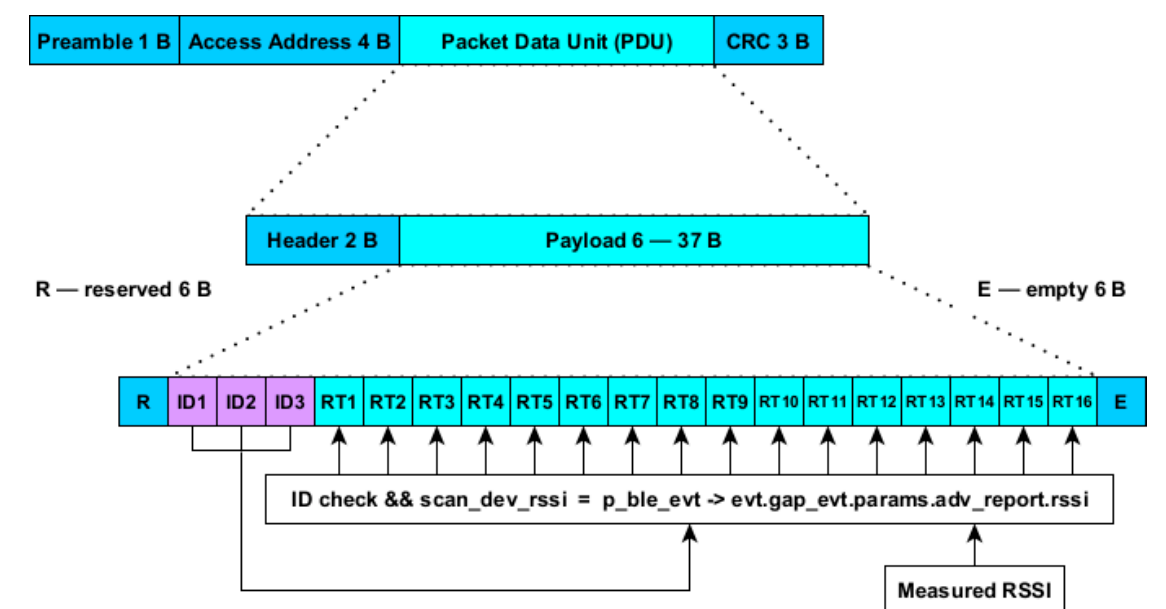
Figure 8. Structure of the advertising frame (Bluetooth LE) used in radio tomography with the location and arrangement of probe ID data and measured RSSI values marked (R—reserved space, E—empty space).